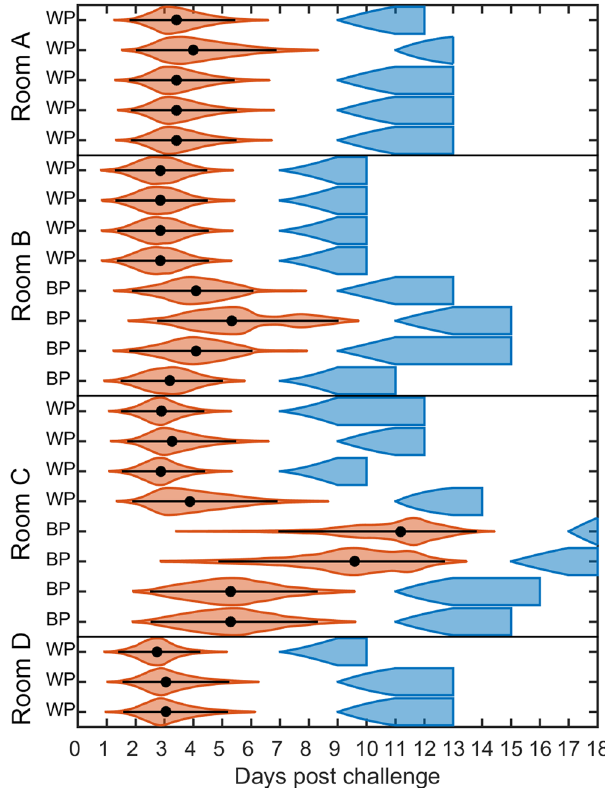
Figure 7. Inferred infection times for the ASFV in pigs transmission experiment. Orange violin plots showing the densities of the inferred infection times for the contact pigs (WP: within-pen contacts; BP: between-pen contacts). The black circles and bars denote the posterior median and 95% highest posterior density interval. The inferred cumulative probability of animals being infectious at each time point are shown in